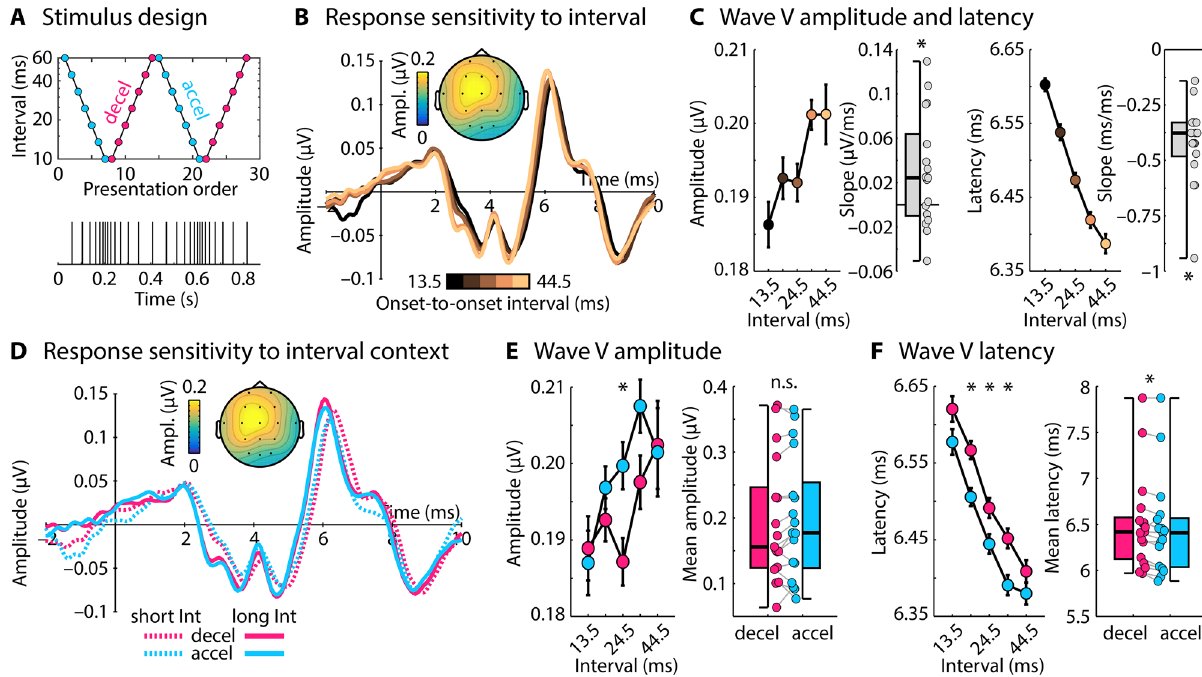
Figure 1. Stimulus design and results for Experiment I. ( A ) Onset-to-onset intervals (logarithmic y-axis) of accelerating and decelerating click sequences. ( B ) Response time courses to clicks, separately for different onset-to-onset intervals to a preceding click. Topographical distribution reflects the mean Wave V (~ 6.6 ms). ( C ) Wave V amplitude and latency as a function of onset-to-onset interval. Box plots and individual data points (dots) reflect the slope from a linear function fit relating Wave V amplitude/latency to onset-to-onset intervals. Wave V latency and amplitude were sensitive to the inter-click-interval (slope significantly different from zero, p ≤ 0.05). ( D ) Response time courses for a short (13.5 ms) and a long interval (44.5 ms), separately for decelerating and accelerating sequence contexts. Topographical distribution reflects the mean Wave V. ( E , F ) Wave V amplitude and latency as a function of onset-to-onset interval, separately for decelerating and accelerating contexts. Box plots and individual data points (dots) reflect the mean difference between amplitudes/latencies for decelerating and accelerating contexts. Amplitudes were larger and latencies smaller in accelerating compared to decelerating contexts (p ≤ 0.05), demonstrating longer-term influences of the acoustic stimulation on the Wave V response. Error bars reflect the standard error of the mean (removal of between- subject variance 61 ). *p ≤ 0.05, n.s. not